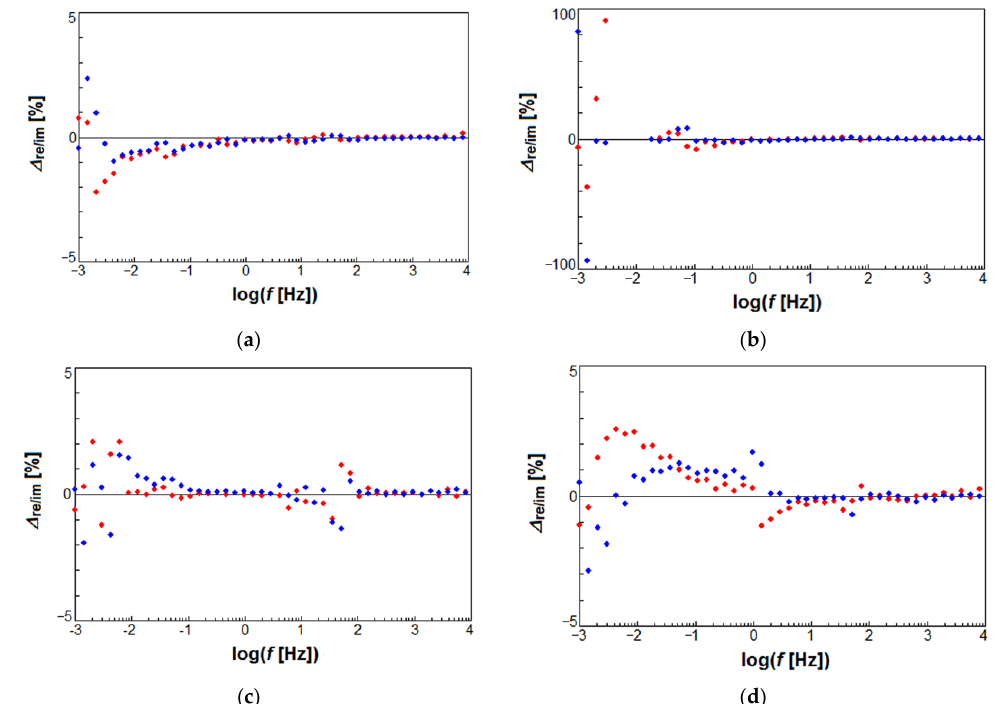
Figure 9. The K–K test residuals for a K–K test of the experimental EIS data obtained at the E cor for the CpTi G2 in 0.1 M KOH solution saturated with O 2 at 25 °C: ( a ) G80 cellular lattice; ( b ) D80 cellular lattice; ( c ) I-2Y80 cellular lattice; ( d ) Bulk. The real and imaginary part differences are represented by red and blue dots, respectively. Materials 2021 , 14 , x FOR PEER REVIEW